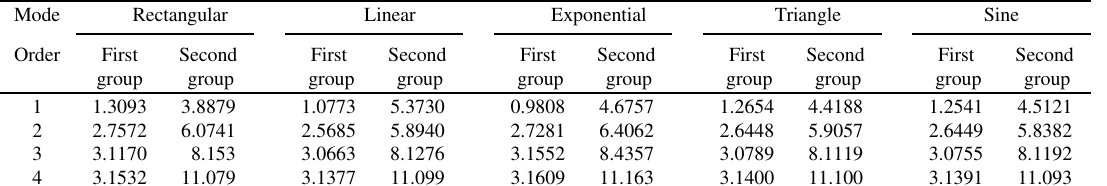
Table 5 Dimensionless modal frequencies of free-clamped beams carrying different distributed spring-mass systems